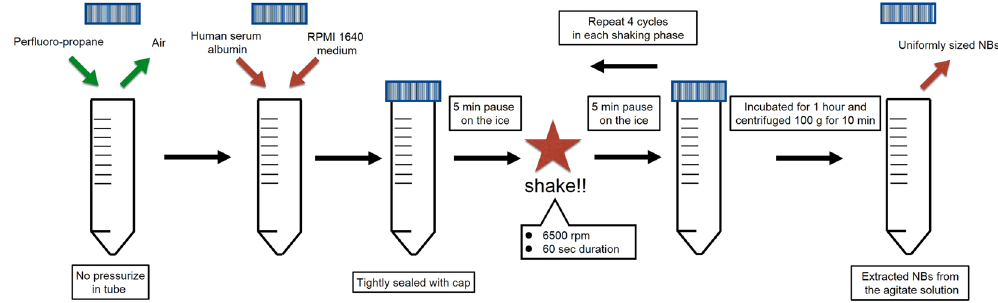
Figure 1. Schematic of the albumin-stabilized nanobubbles manufacturing